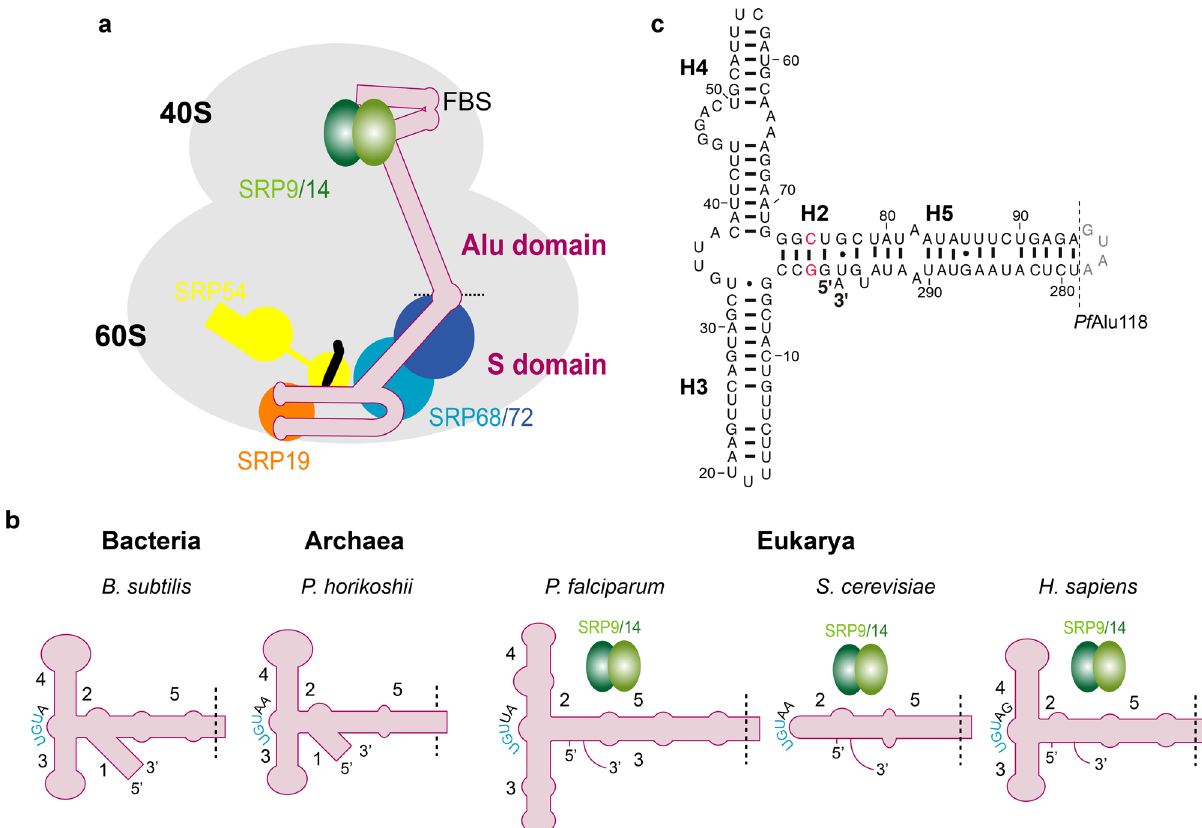
Fig. 1 Architecture of the SRP Alu domain. a Schematic showing the composition of the eukaryotic SRP bound to the ribosome-nascent chain complex (RNC). b Schematic representation of SRP Alu RNA from the three domains of life: Bacteria, archaea, and eukarya. SRP9/14 proteins are shown for organisms where they have been annotated. A dashed line indicates the border between the Alu and S domains. The conserved UGU motif is colored in blue. c Construct for the entire Pf Alu RNA ( Pf Alu118) where the S domain is replaced by a GUAA tetraloop (gray). Base-pair information is depicted as previously predicted 8 . Nucleotides mutated due to the hammerhead ribozyme and T7 RNA polymerase production requirements are highlighted in